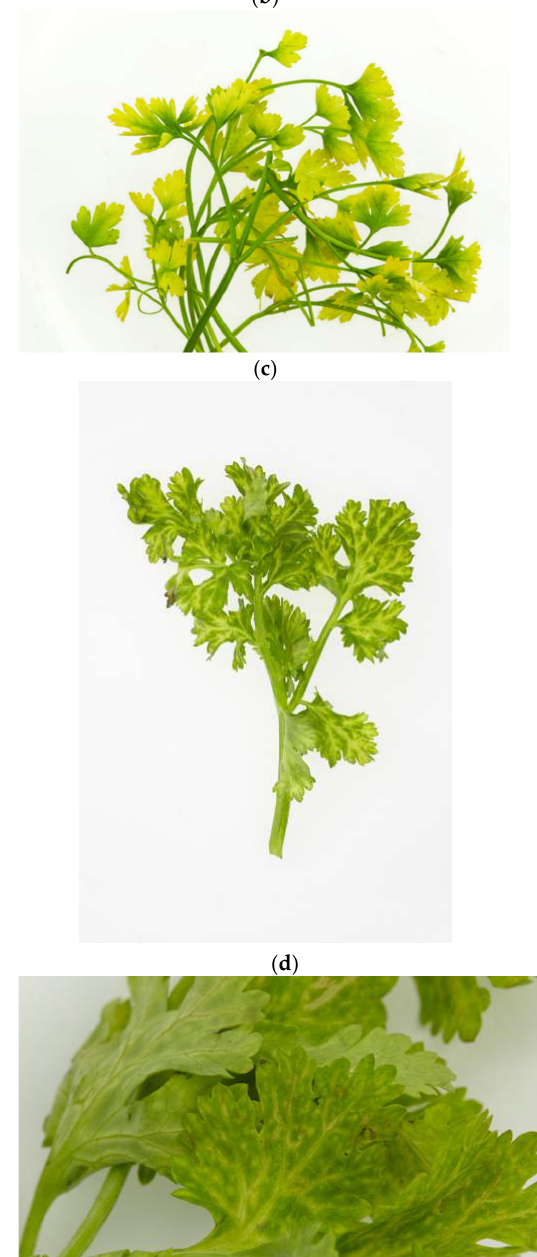
Figure 5. Photographs of symptoms in leaves from apiaceous samples intercepted by UK plant health and seeds inspectors; ( a ) Sample 21506527, coriander showing chlorotic spotting; ( b ) Sample 21604167, parsley showing general chlorosis and chlorotic mottle; ( c ) Sample 21625530, coriander showing vein yellowing and chlorotic mottle; ( d ) Sample 21806162, coriander showing vein yellowing and chlorotic spotting.